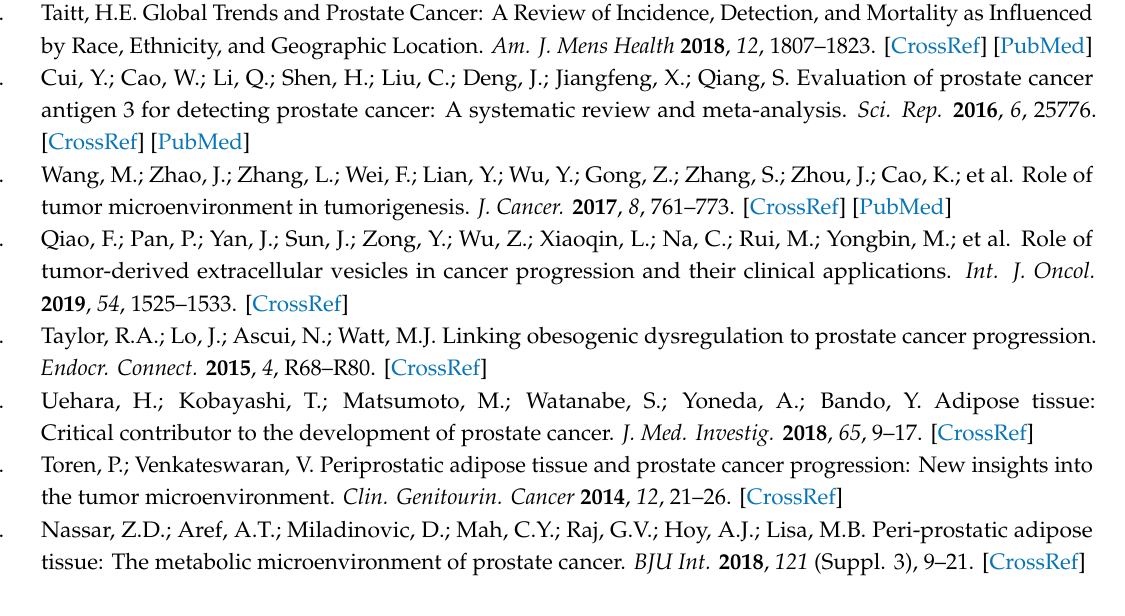
Figure S1: Chemokine-mediated migration of preadipocytes and TAMs, Figure S2: SFMBT2 regulates migration of preadipocytes and TAMs in PC3 cells, Figure S3: Expression level of SFMBT2, Pref-1, CD24, CD29, CD163, CD206, C / EBP α , FABP4, and Sca-1 in tumor xenograft, Figure S4: No enrichment of SFMBT2 to CXCL8, CCL2, CXCL10, and CCL20 gene promoters in LNCaP cells, Figure S5: Preadipocytes and TAMs promote migration and invasion of prostate cancer cells through up-regulation of IL-6, Figure S6: Knockdown of SFMBT2 results in up-regulation of TNF α expression, Figure S7: Uncropped western blot figures of Figure 5D (A) and Figure S2C (B), Table S1: Oligonucleotides used in this study, Table S2: Antibodies used in this study, Table S3: Chemokines and cytokines used in this study, Table S4: Characteristics of prostate cancer patients in tissue array used in this study, Table S5: Relationship between the expression level of SFMBT2 and Gleason